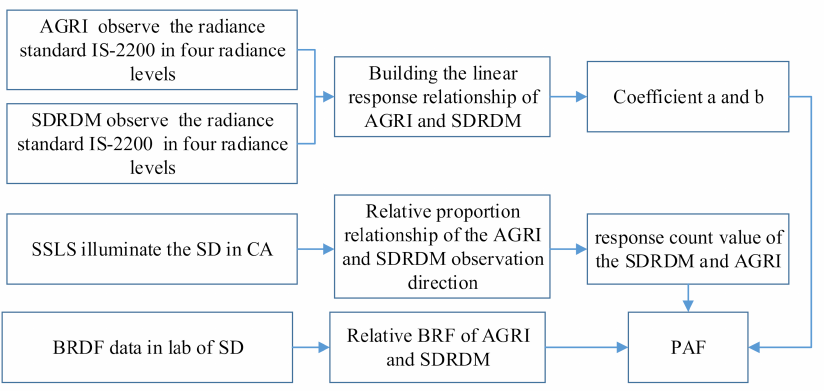
Figure 2. The flowchart of the PAF measurement.